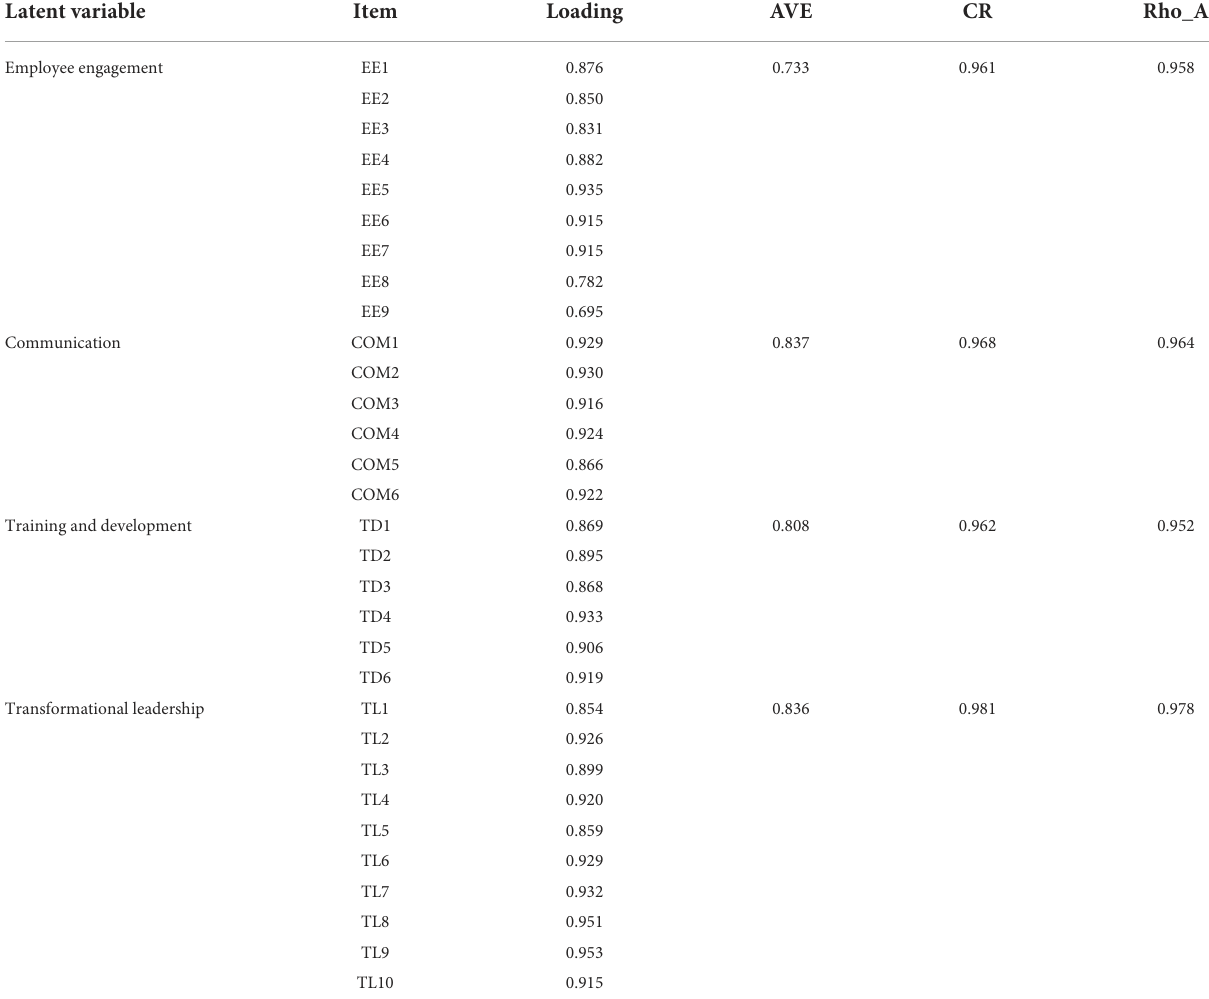
TABLE 2 Results for the assessment of the measurement model. Latent